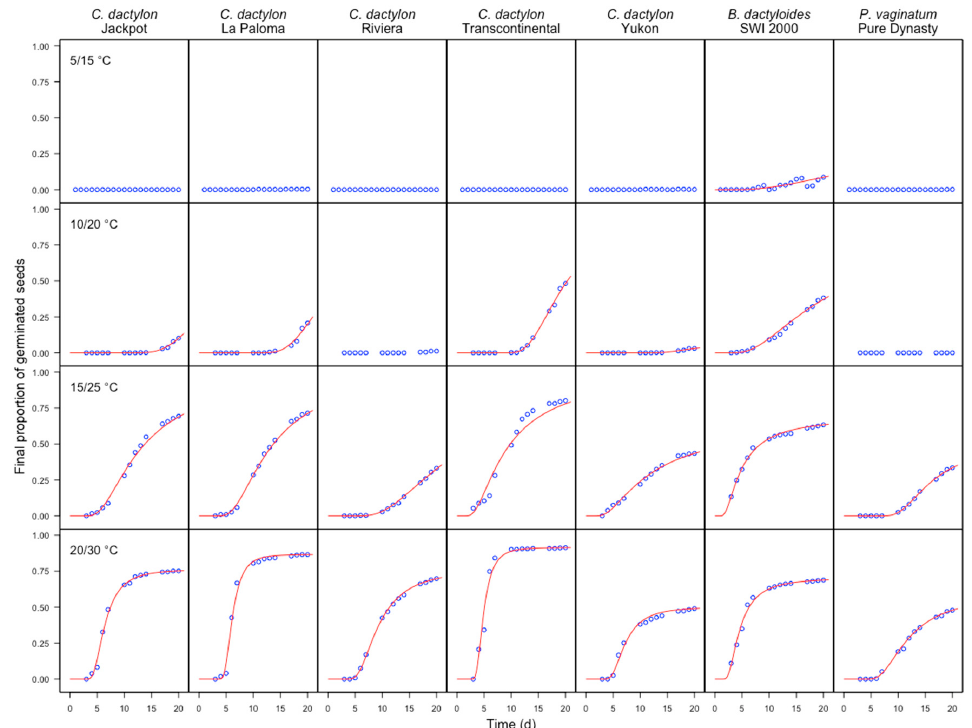
Figure 1. Time course of germination for seven cultivars of warm-season turfgrass species (Jackpot, La Paloma, Riviera, Transcontinental, Yukon; SWI 2000, Pure Dynasty; each variety is shown in a different column of the panel graph) subjected to four temperature regimes (5/15 °C, 10/20 °C, 15/25 °C, 20/30 °C; each temperature regime is shown in a different row of the panel graph). Symbols represent observed data and solid lines show the fitted models (Equation (1), together with the parameters in Table S1). The observed data represent the means of six blocks and two runs. Fitted curves were used to derive the germination rates for the 10th, 20th, and 30th percentiles (GR10, GR20, GR30), which were used to parameterise Equation (2). The fit was always good; in agreement with Bradford [44], the three linear relationships of GR10, GR20 and GR30 merged at the intercept of the x-axis, confirming that Tb was equal for all seeds of the lot (Figure 2, Table 3) [44].